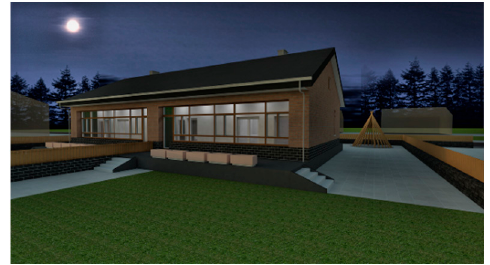
Figure 9. S outh façade of the demonstration building.